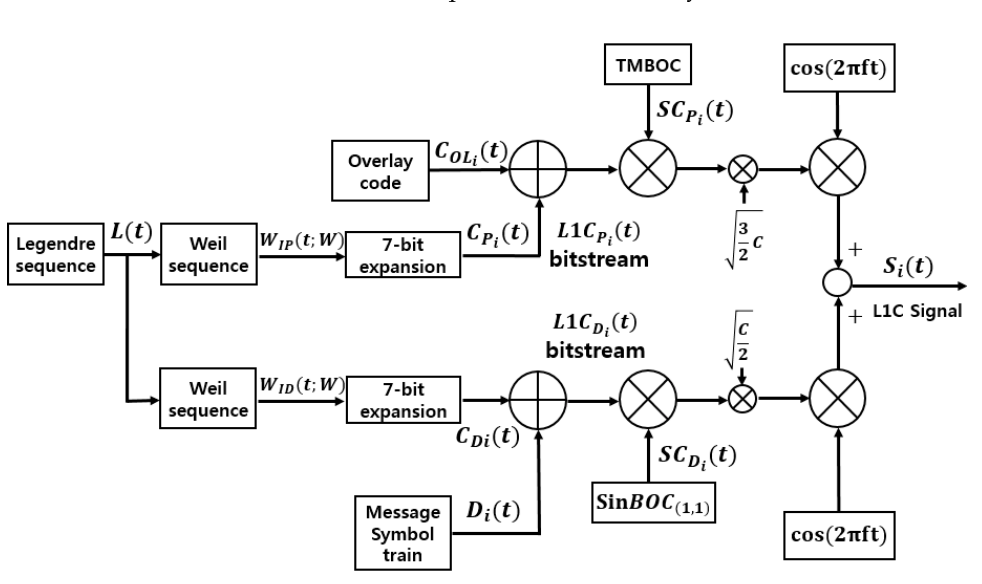
Figure 1. GPS L1C signal structure.